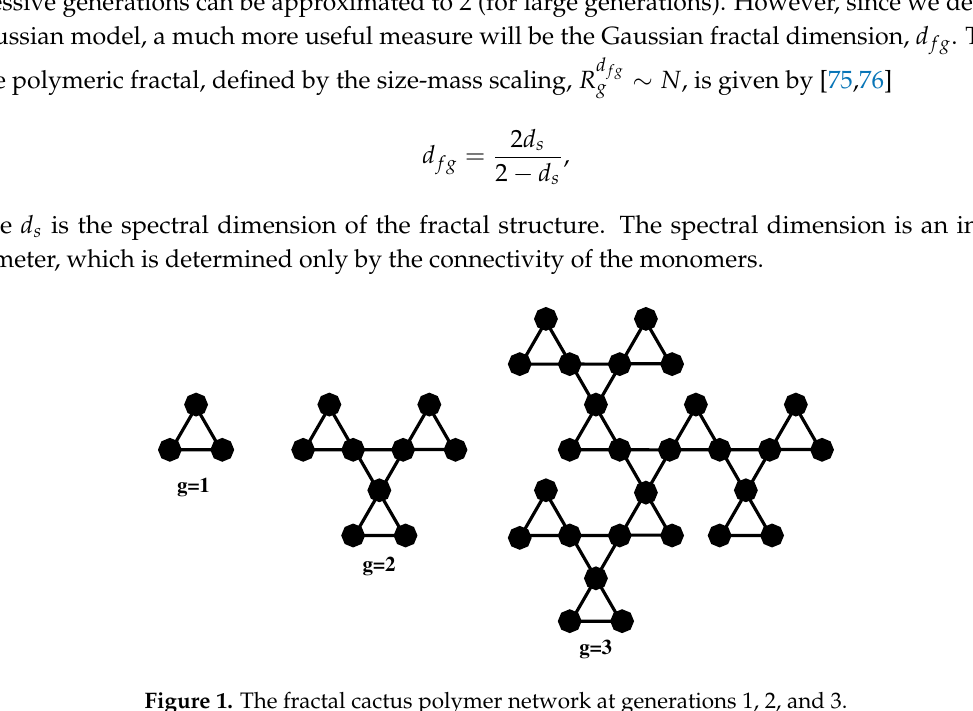
Figure 1. The fractal cactus polymer network at generations 1, 2, and